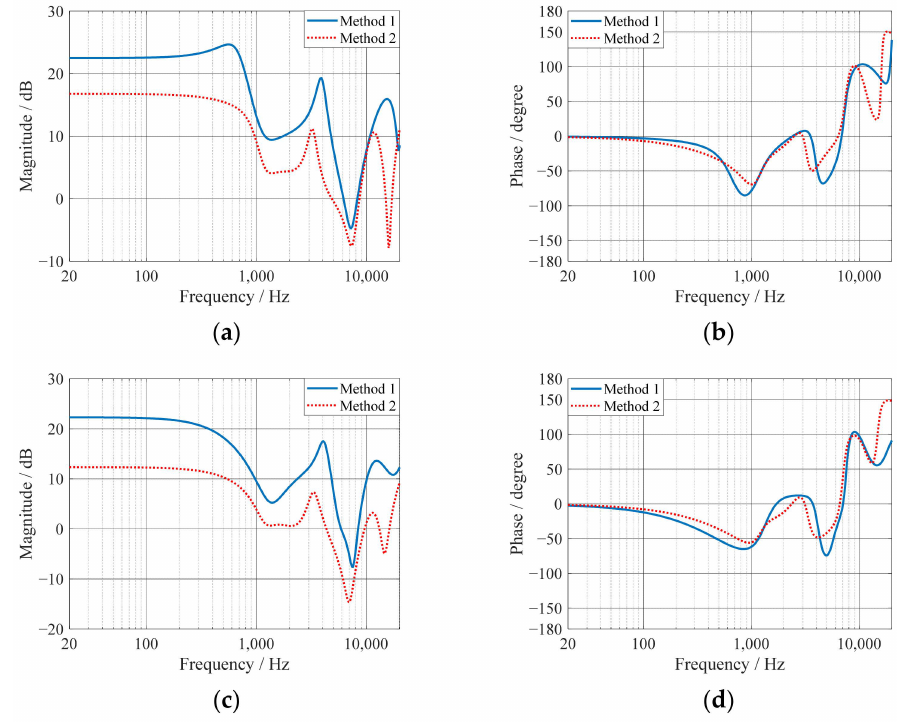
Figure 4. The FRs of designed controllers with different methods: the ( a ) magnitude and ( b ) phase responses with a 5 dB noise enhancement limitation, the ( c ) magnitude and ( d ) phase responses with a 3 dB noise enhancement limitation.